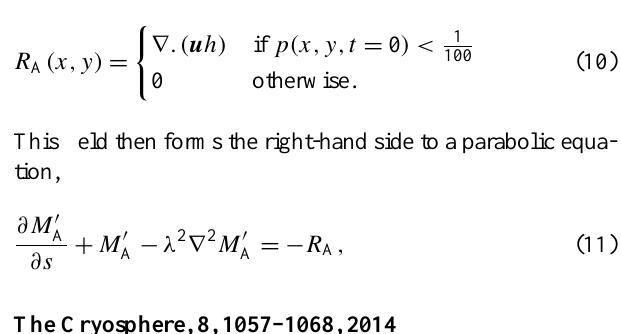
Fig. 3. Initial melt rate distribution M 0 b ( x,y,t = 1982) and HadCM3/A1B/FESOM melt rates M b ( x,y,t ) for the years 2100 and 2200. M 0 ( x,y,t ) is computed from equation (9) to maintain elevated melt rates close to the grounding line. Time dependent melt M b ( x,y,t ) rates b are computed by adding anomalies, computed with respect to the 1980-1990 mean, to M 0 b ( x,y,t ) . The HadCM3/A1B/FESOM extended melt rate anomalies are constructed as the ice sheet evolves by extrapolating the HadCM3/A1B/FESOM data into floating regions outside the present day ice shelf.